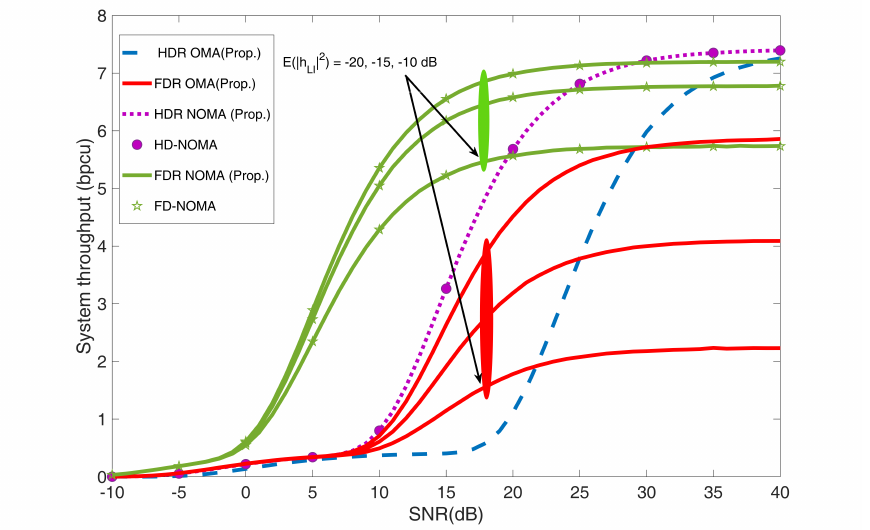
Figure 3. System throughput versus SNR for UAV-HDR/FDR − based NOMA and OMA schemes with different values of LI for B = 2 (Rayleigh fading based HD/FD − NOMA